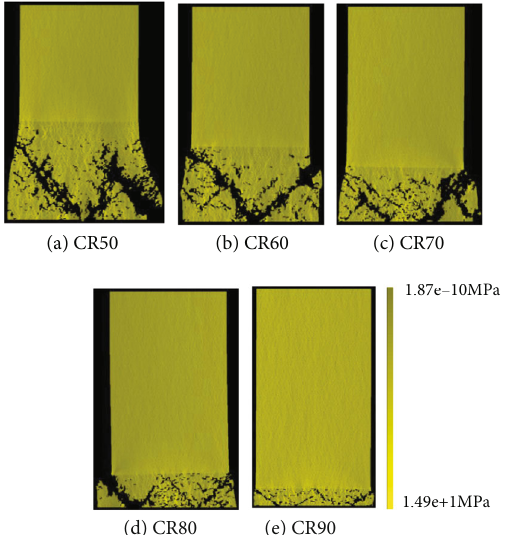
Figure 3: Fracture patterns of samples with di ff erent coal and rock height ratios without water